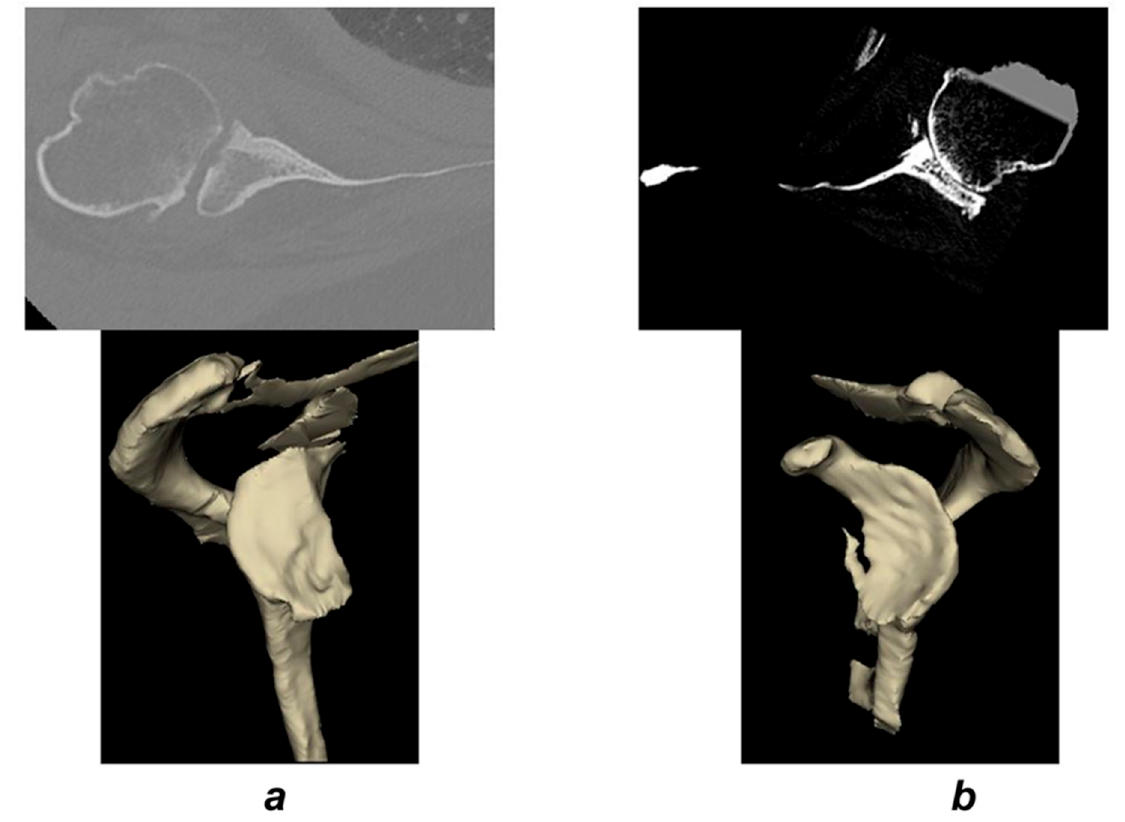
Figure 4. The CT scan appearance was either biconcave ( a ) or uniconcave ( b ).